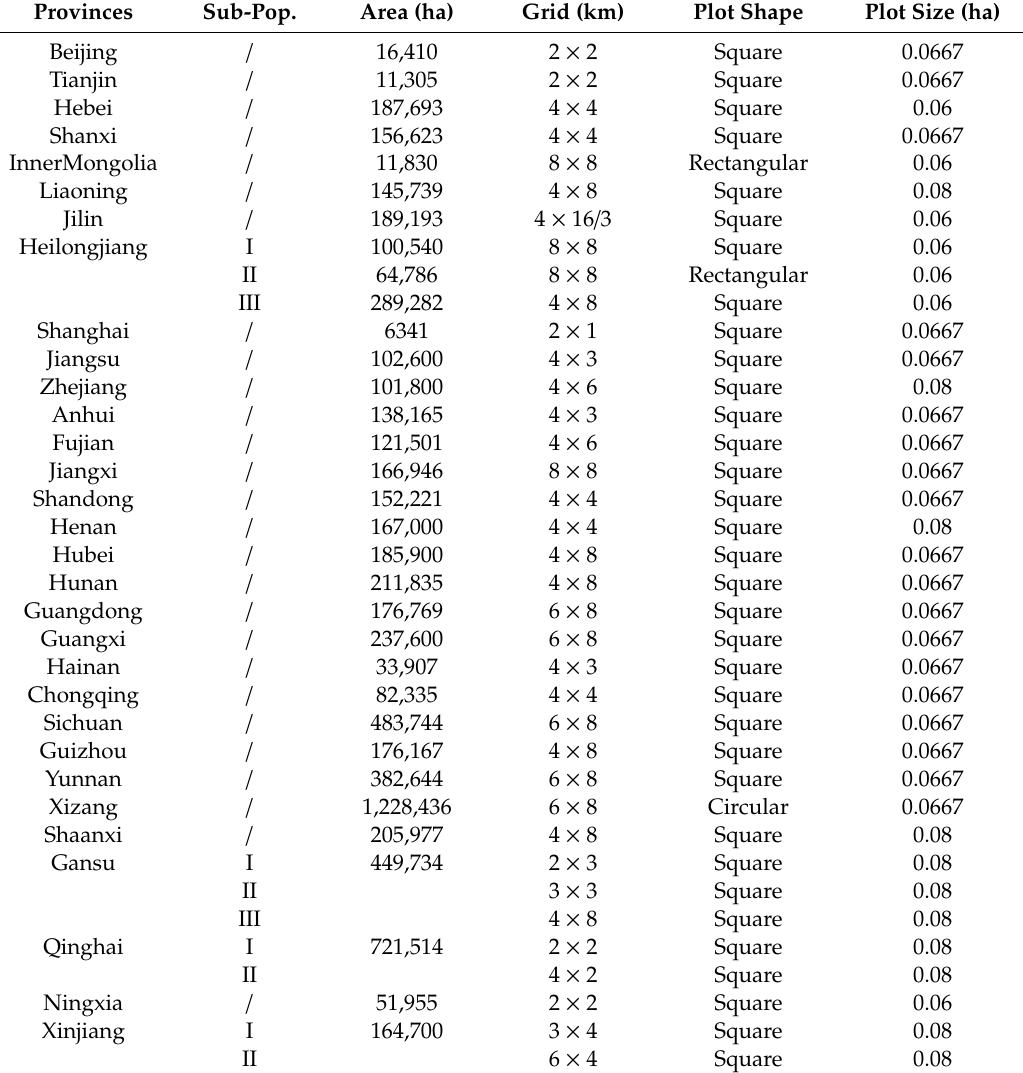
Table A1. Sampling designs for 31 provinces in China’s forest resources